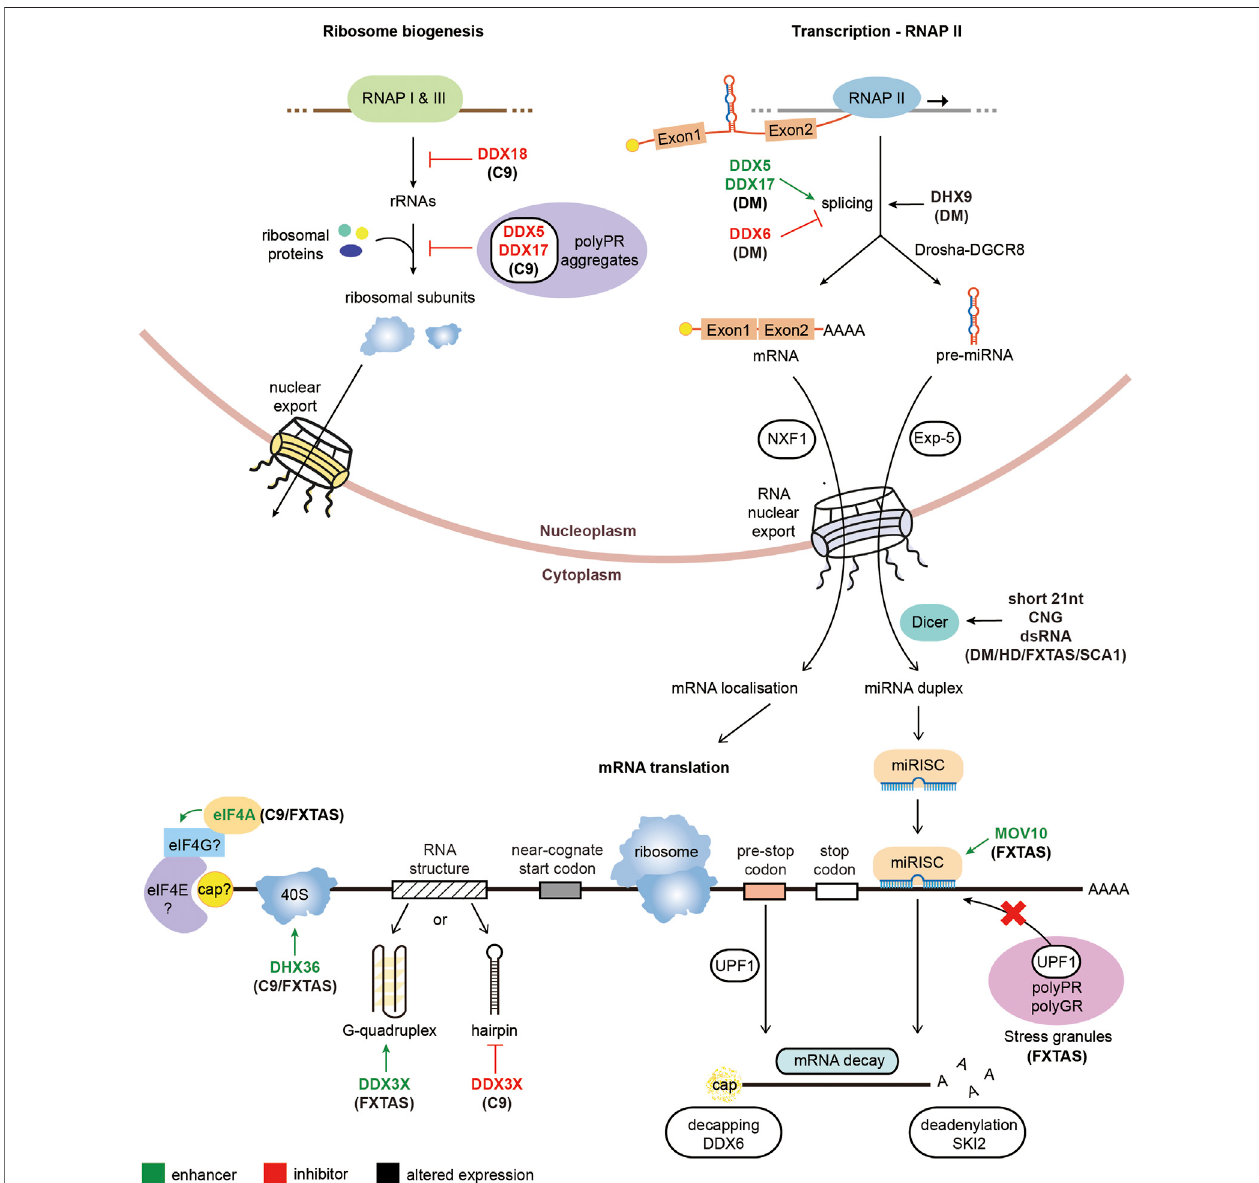
FIGURE2| PathologicalrolesofRNAhelicasesinmicrosatelliteexpansiondisorders.DiagrammaticrepresentationofRNAmetabolicfunctionswithRNAhelicases implicated in repeat expansion diseases. RNA helicases labeled in green enhance the arrow-indicated processes while RNA helicases typed in red inhibit the corresponding highlighted step of gene expression. On the other hand, RNA helicases with black text have altered expression levels in the associated repeat expansion disorders.